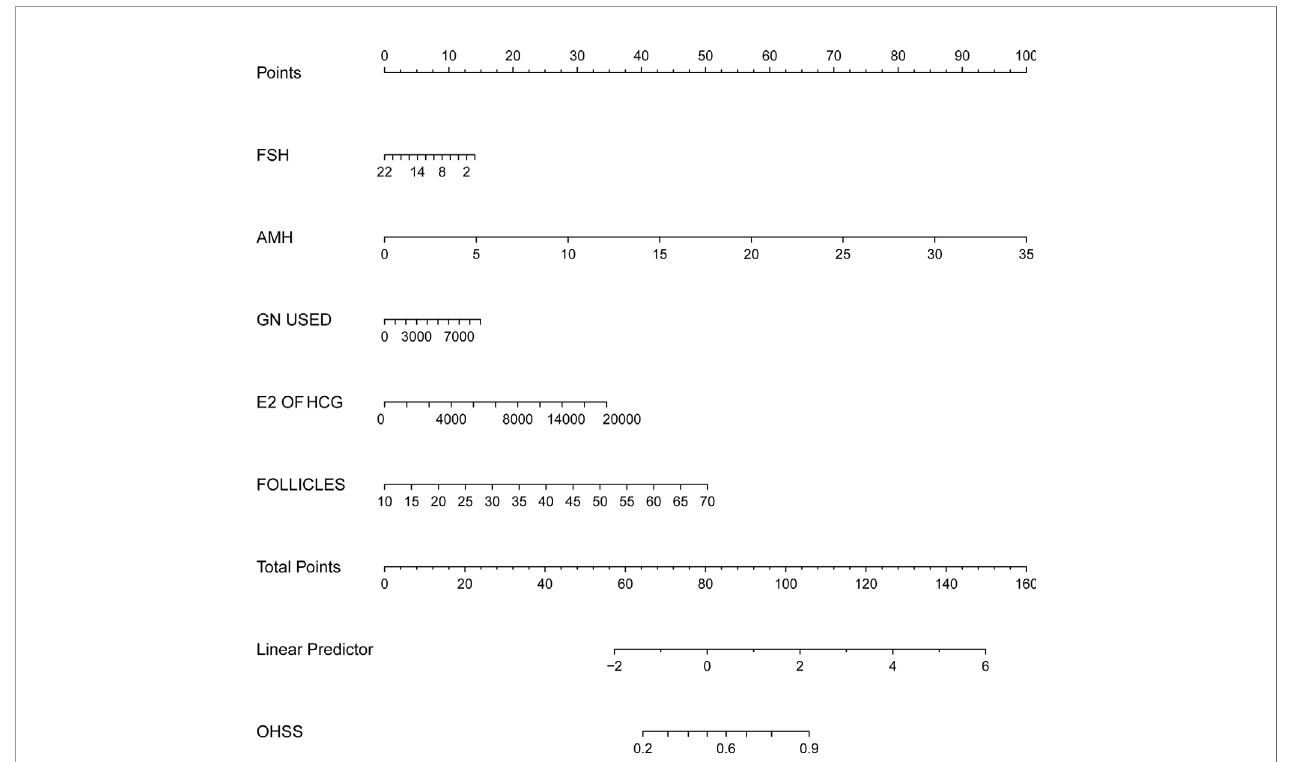
FIGURE 1 | Nomogram to predict the probability of OHSS in PCOS related infertility patients. The probability of OHSS is calculated by drawing a line to the point on the axis for each of the following variables: FSH, AMH, E2 value on the day of hCG injection, total dosage of Gn used and follicle number on the day of hCG injection. The points for each variable are summed and located on the total points line. Next, a vertical line is projected from the total points line to the predicted probability bottom scale to obtain the individual probability of